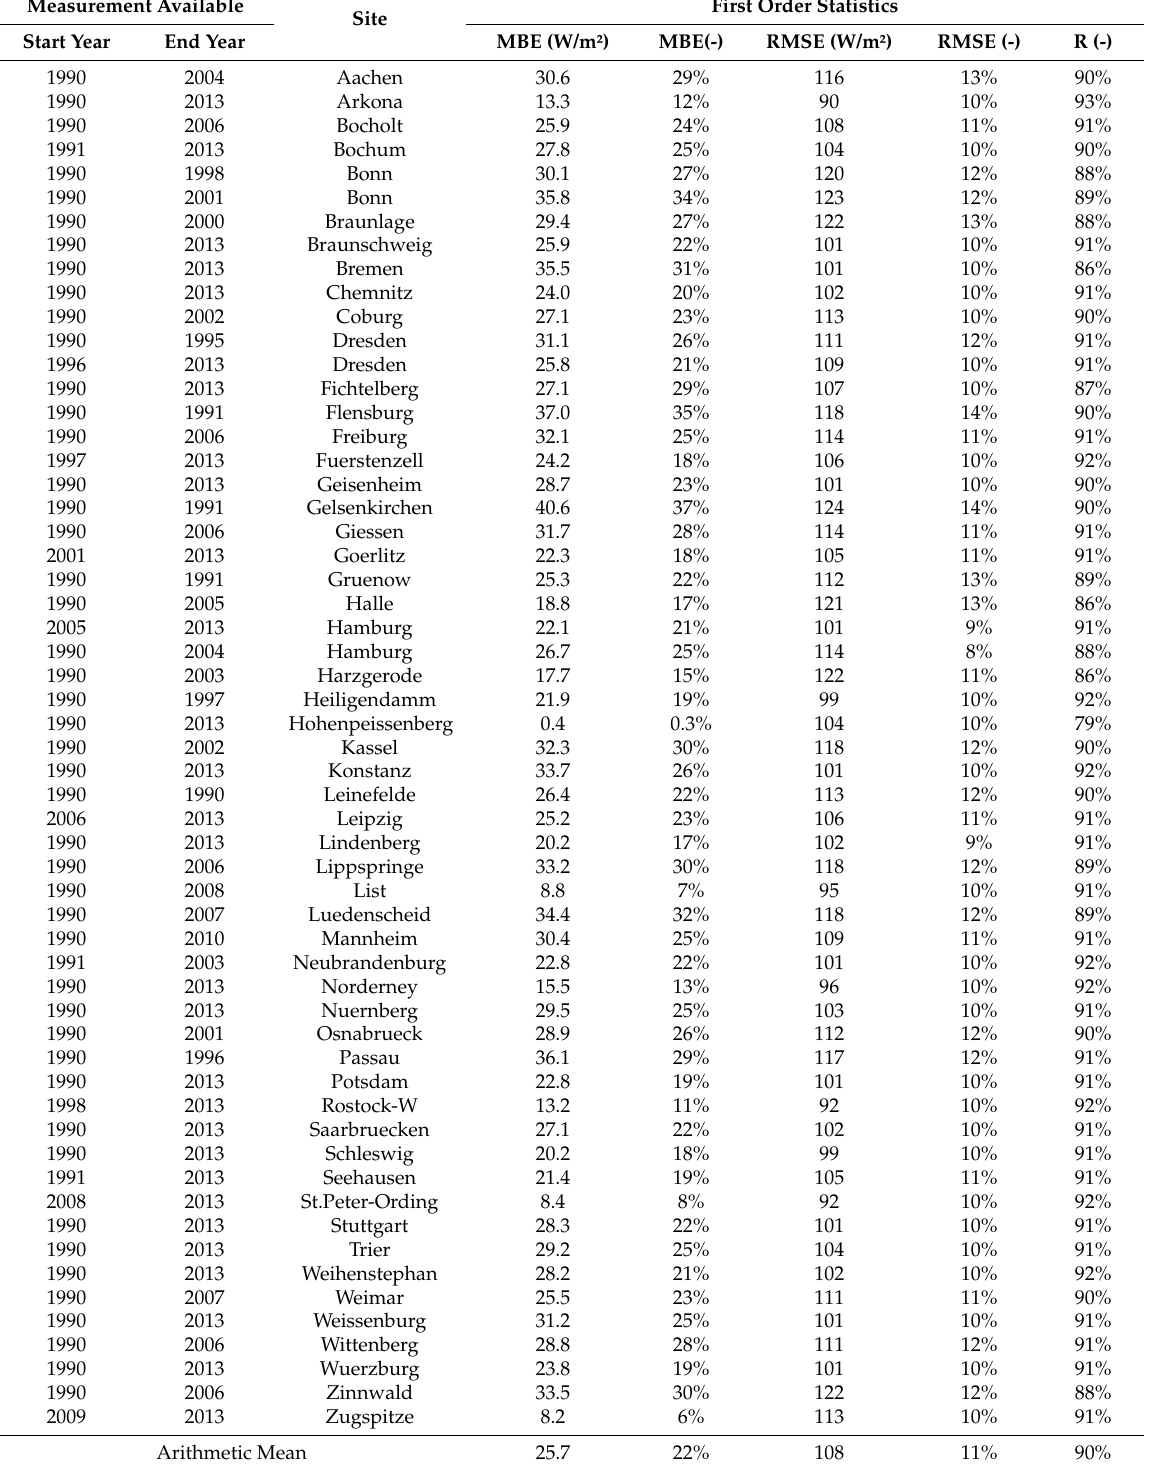
Table 1. Selected statistics for the 57 sites with measurement data available. Model data was available through 1990–2013, measurements were only available as noted in columns 1 and